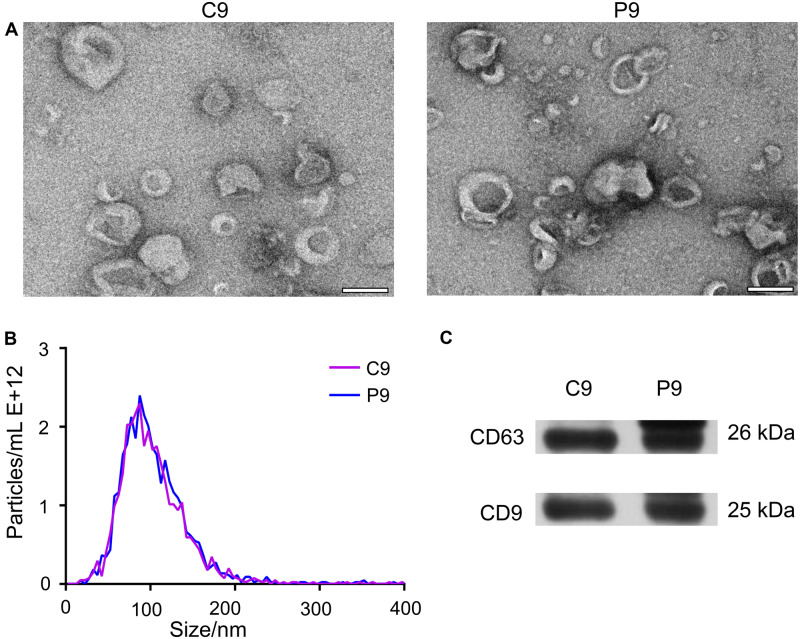
Characteristics of exosomes during early pregnancy. (A) TEM revealed vesicles with sizes of about 100 nm, consistent with those of exosomes. Representative TEM micrographs of exosomes derived from sera on day 9 (n = 3) of the estrus cycle (C9) and on day 9 (P9) of pregnancy. Scale bar = 100 nm. (B) NTA showed that most of vesicles were 30–150 nm in diameter. The profile confirmed the size measurement from TEM micrographs. (C) Western blot showing the presence of exosomal markers CD63 and CD9 in serum-derived exosomes from cyclic and pregnant pigs.